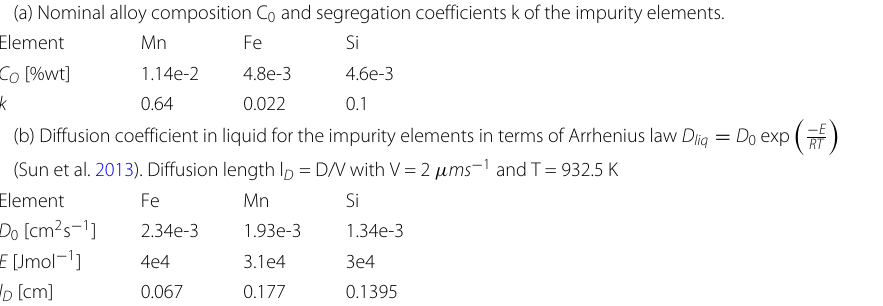
Table 1 Alloy composition and diffusion